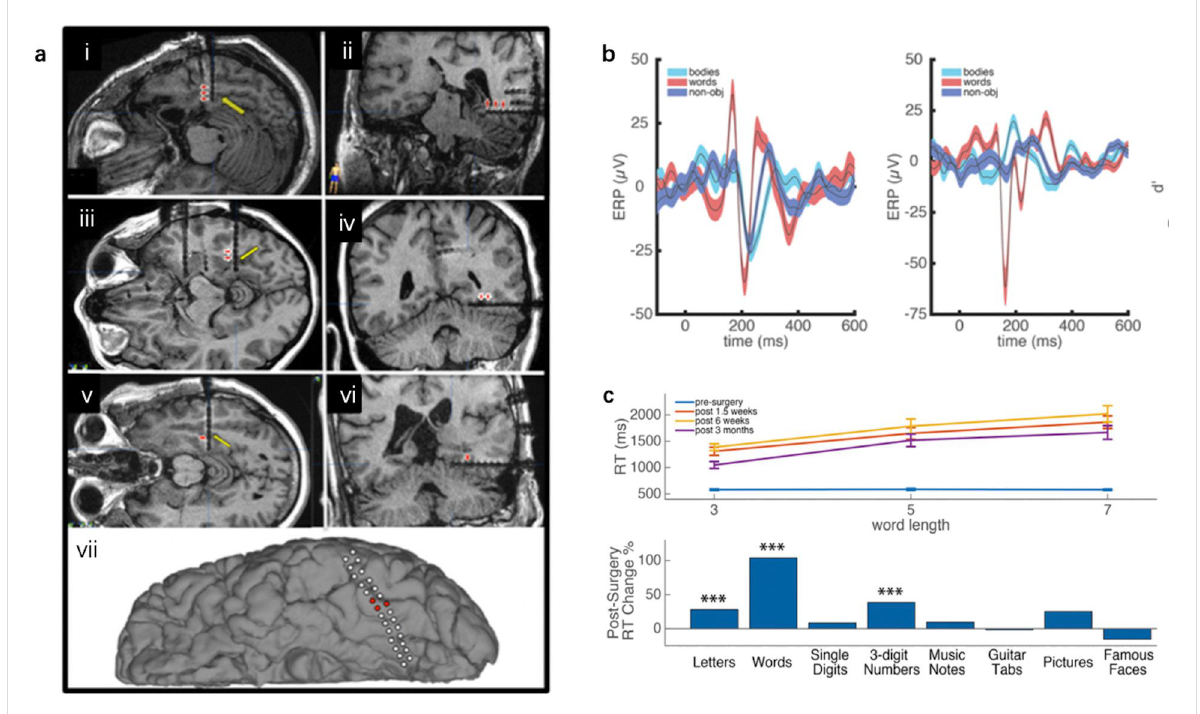
Figure 3: iEEG recording of patients with medically intractable epilepsy. (a) Electrodes were implanted in the ventral temporal cortex of the patients. (b) The signals showed a strong early-stage sensitivity to words at 100–400 ms. (c) The results from the word length and naming task showed that Patient 1 suffered from acquired alexia after surgery. Figure 3 was adapted from [54], Proceedings of the National Academy of Sciences of the United States of America, vol. 113, By E. A. Hirshorn; Y. Li; M. J. Ward; R. M. Richardson; J. A. Fiez; A. S. Ghuman, “Decoding and disrupting left midfusiform gyrus activity during word recognition”, pp 8162–8167, with permission from National Academy of